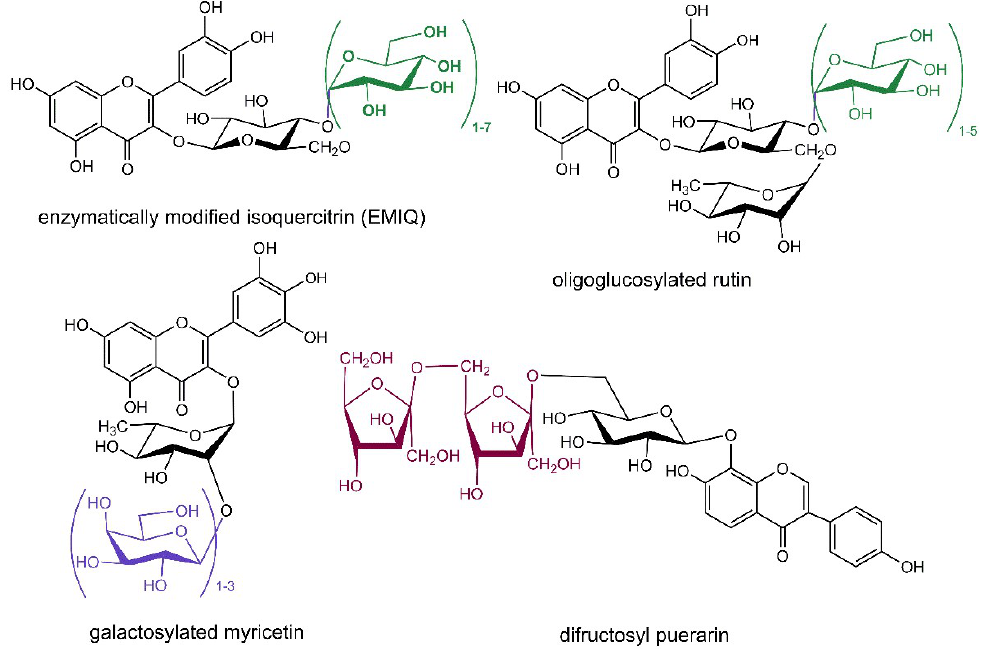
Figure 2. Structures of oligoglycosylated conjugates of flavonoids obtained by transglycosylation reactions. The conjugated sugar moieties are shown in green (β- D -glucopyranose), violet (β- D -galactopyranose) and dark red (β- D -fructofuranose) color.